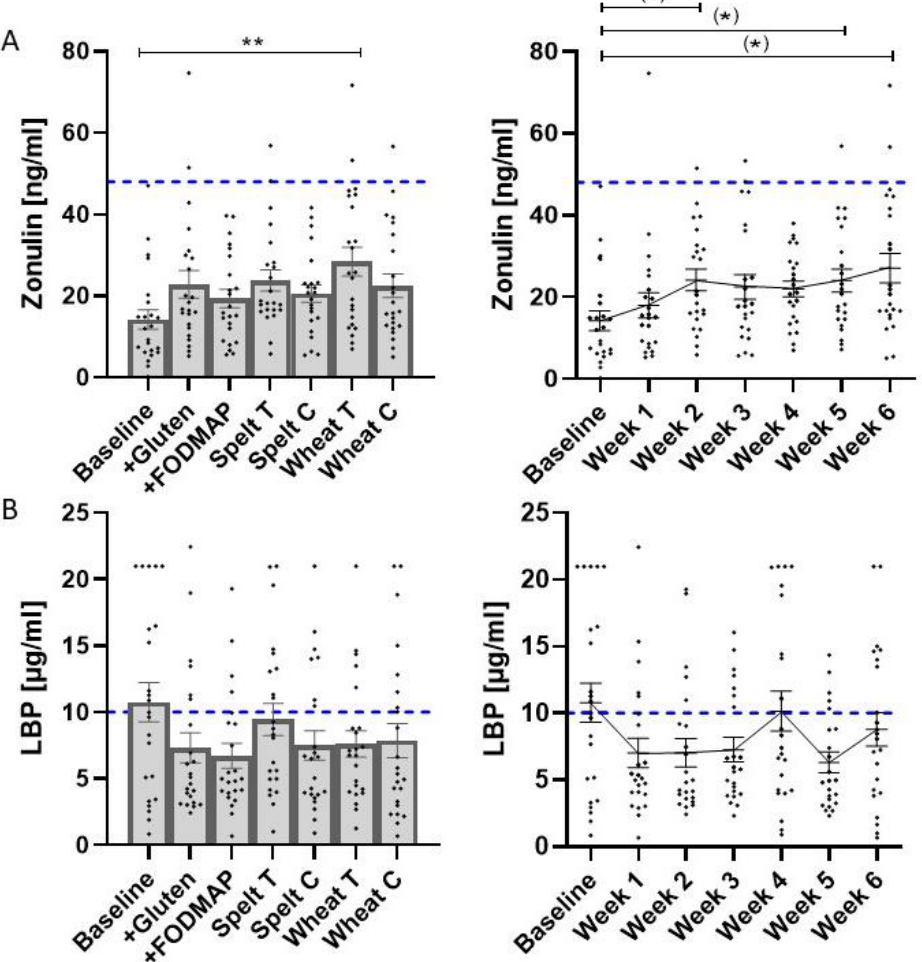
Figure 4. Parameters for gut permeability evaluation. The individual values for zonulin ( A ) and LBP ( B ) concentration, mean, and SEM after the different study breads (left) and over time (right) are shown. The reference values (<42 ng/mL for zonulin and <10 µg/mL for LBP) are shown by the dashed line. Abbreviations: LBP, lipopolysaccharide-binding protein; FODMAP, fermentable oligo-, di-, monosaccharides and polyols; T, traditional recipe; C, current recipe. Statistics by Fried- man/Dunn. ( * ) p < 0.1; ** p < 0.01.